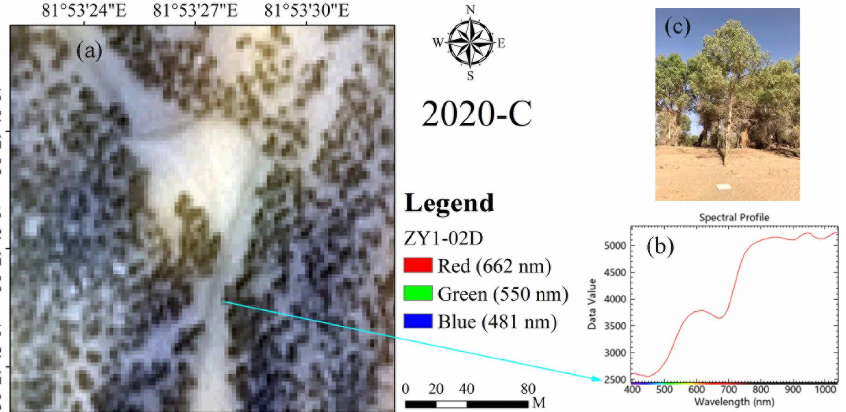
Figure 16. Schematic diagram of 2020-C (100 m × 100 m) verification quadrat. ( a ) The fused ZY1-02D true color image. ( b ) Spectral curve of Populus euphratica crown on ZY1-02D hyperspectral imagery. ( c ) Field photo of Populus euphratica marked with colored plates.